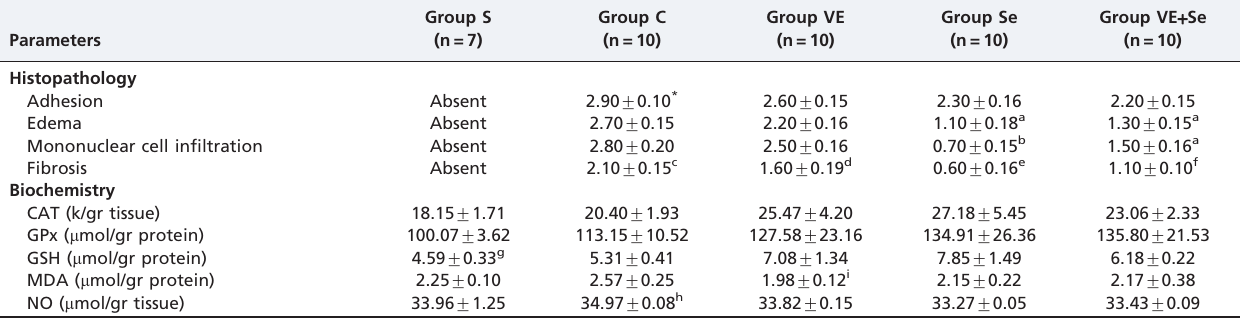
Table 1 - Incidence of histopathological lesions in uterus sections and mean tissue levels of CAT, GPx, GSH, MDA and NO (values shown as mean ¡